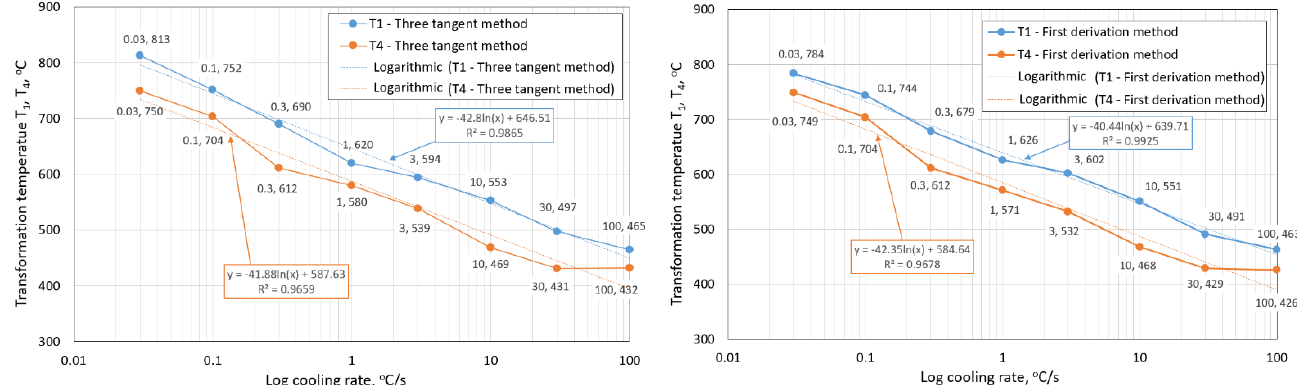
Figure 9. The influence of the cooling rate on transformation temperatures T 1 and T 4 : left —three tangent method; right —first derivation method.